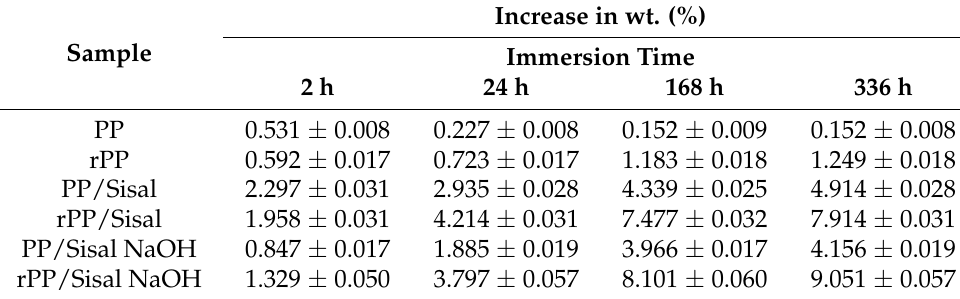
Table 2. Water absorption results of processed formulations.